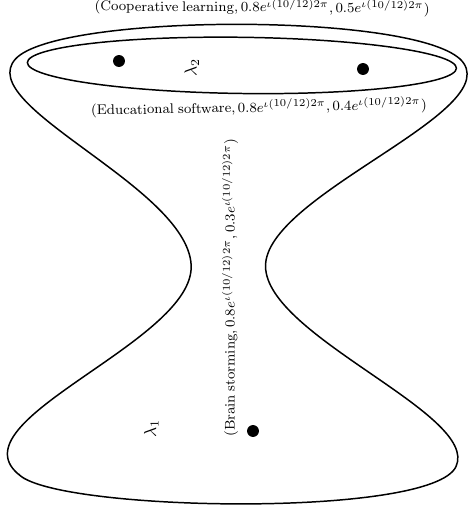
Figure 12. Complex intuitionistic fuzzy hypergraph model of teaching